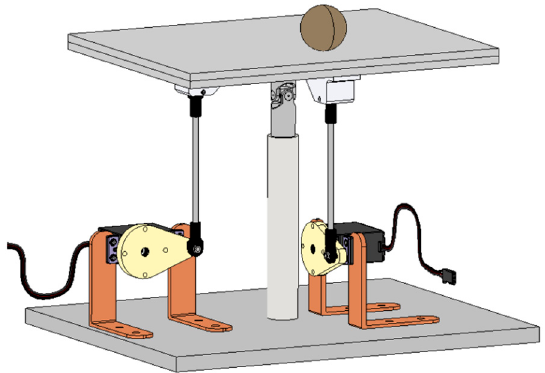
Figure 1. Ball-On-Plate illustration.